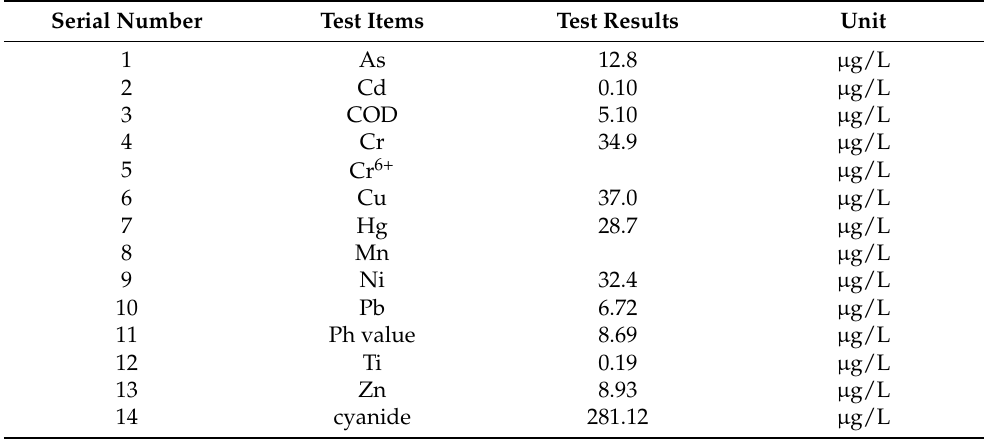
Table 1. Detection results for discharge wastewater from a sodium ion battery of a new energy battery company after one